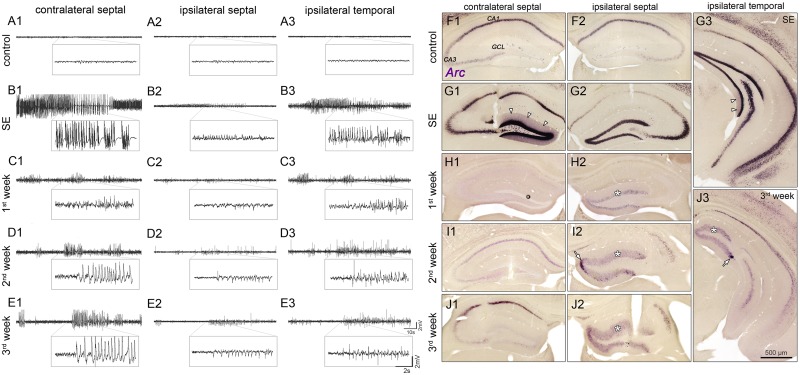
Spatiotemporal patterns of hippocampal activity during the development of mTLE. (A) Representative LFP recordings from three regions in the hippocampus of a saline-injected control mouse (1, contralateral septal; 2, ipsilateral septal; and 3, ipsilateral temporal) and (B–E) of one epileptic mouse at different time points (B, SE; C, first week; D, second week; E, third week) following KA injection. Note, that epileptiform activity is present throughout epileptogenesis, exhibiting position-dependent differences in power of paroxysmal discharges: Low amplitudes in the sclerotic (ipsi septal) hippocampus; high amplitudes in non-sclerotic regions (contra septal; ipsi temporal). (F–J) Corresponding time course of Arc mRNA expression. CA1/3, cornu ammonis 1 and 3; GCL, granule cell layer. Arrow heads in G1 and G3 denote dendritic translocation during SE. Arrows in I2 and J3 mark increased Arc expression near the transition to the non-dispersed GCL in chronic epilepsy. Note that in the ipsilateral GCL Arc expression persists for 3 weeks during epileptogenesis (asterisks).